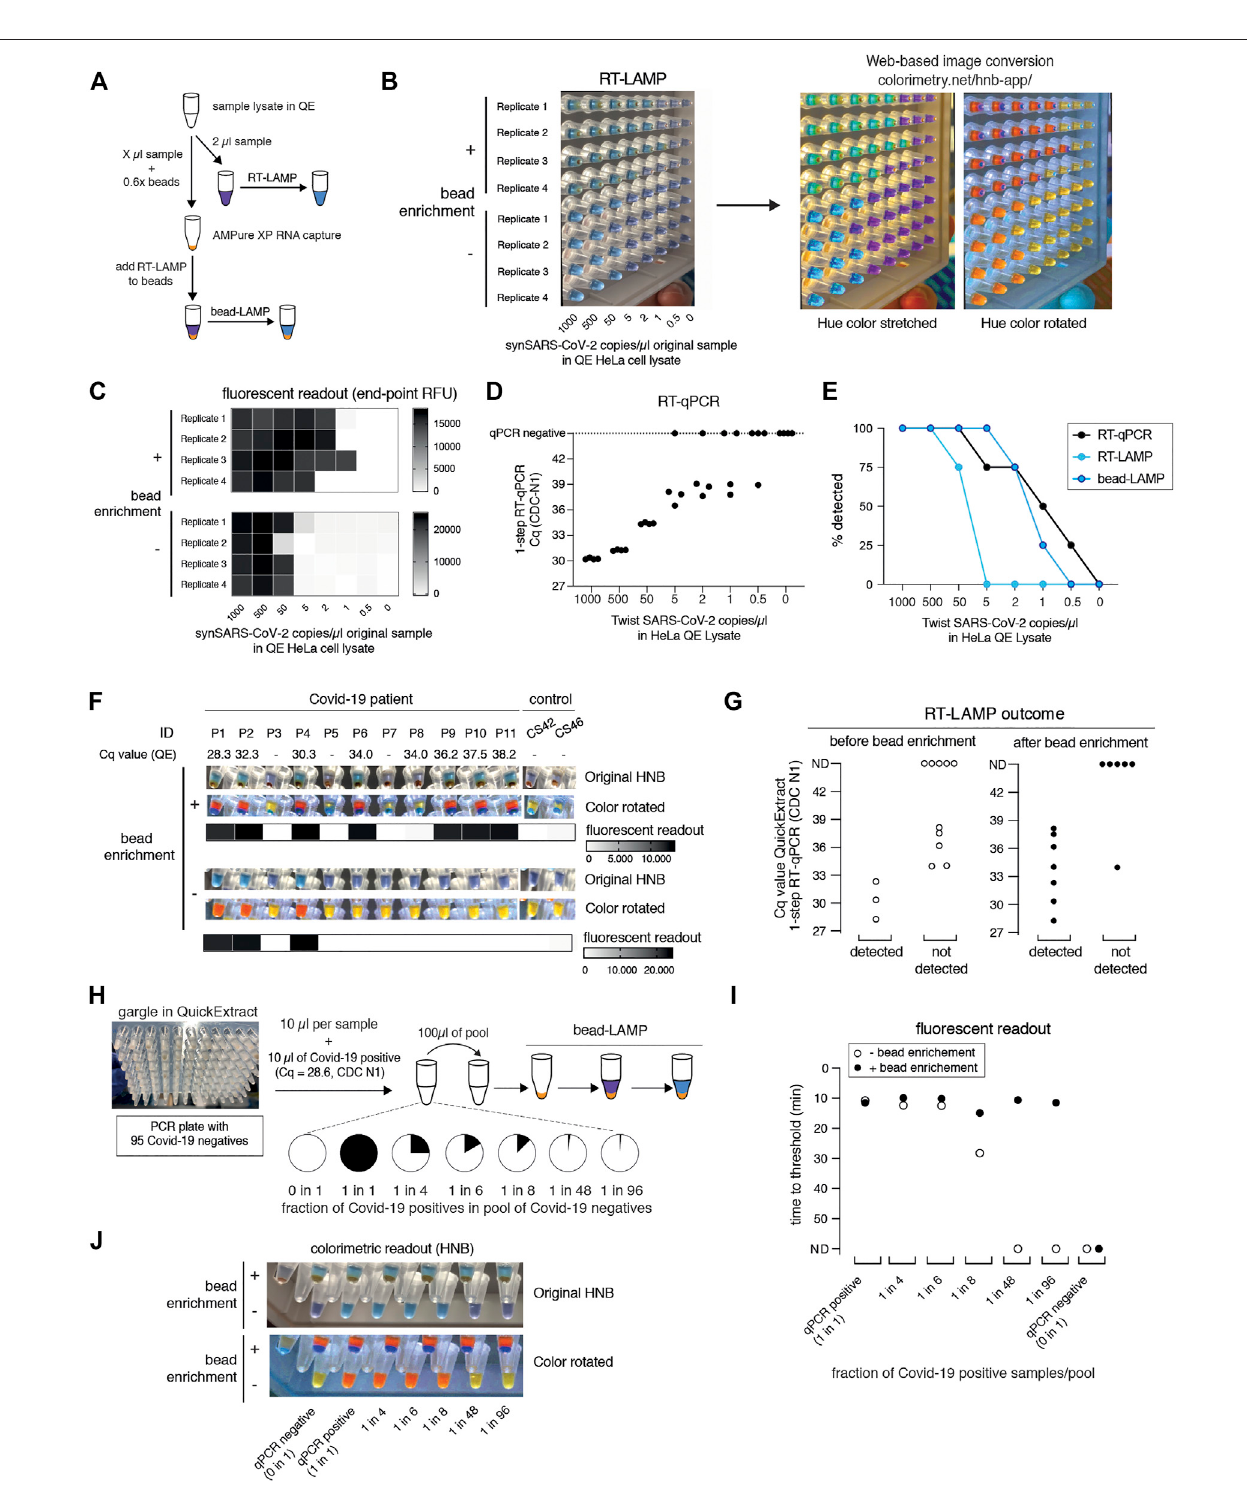
FIGURE 4 | bead-LAMP increases sensitivity of RT-LAMP assays. (A) Schematic illustrating the bead-LAMP work fl ow in comparison to the regular RT-LAMP work fl ow. AMPure XP RNA capture beads were used at 0.6x of the volume of the sample lysate (0.6x beads). (B) Performance of bead-LAMP (+ bead enrichment) vs. regular RT-LAMP ( − bead enrichment) using a synthetic SARS-CoV-2 RNA standard spiked-in at the indicated concentration in the original sample into HeLa cell QuickExtract (QE) lysate. 50 µl of crude sample in QE, adjusted to 100 µl fi nal volume with 1x HBSS was used for bead-enrichment. The image shows HNB end- point colorimetric readout of bead-LAMP and RT-LAMP reactions, as well as the color-converted images produced with colorimetry.net on the right. All reactions were